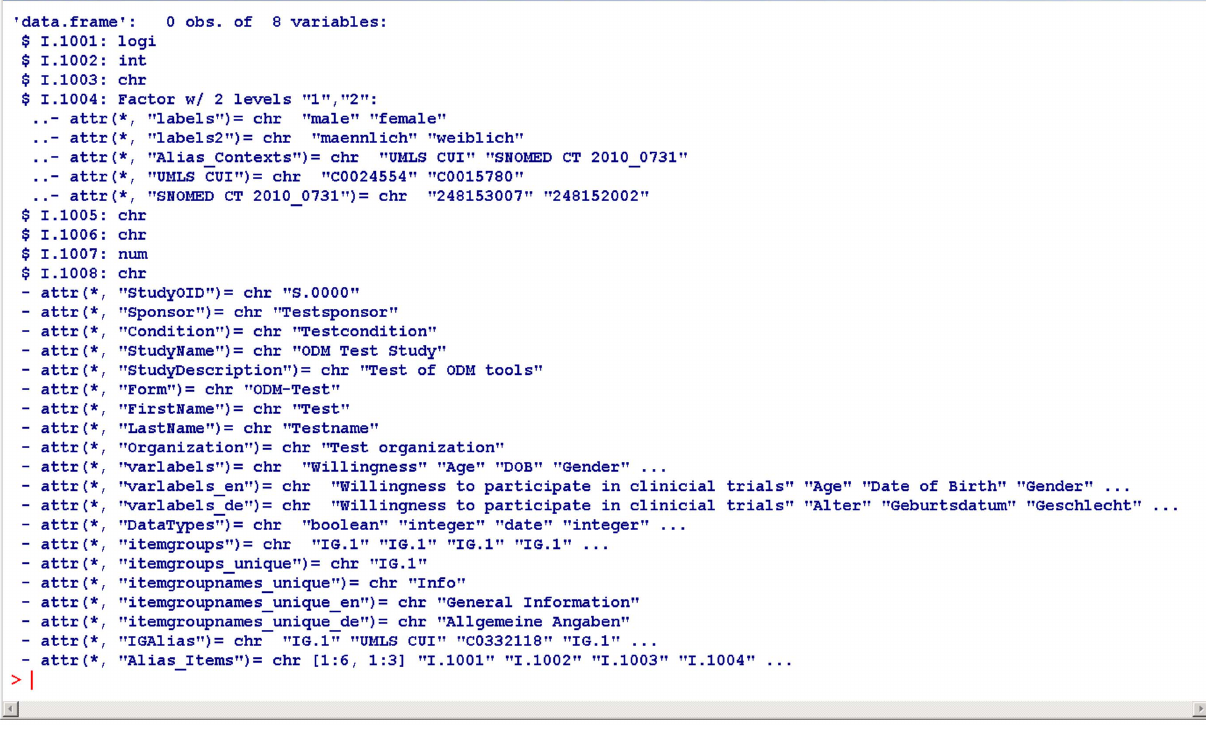
Table 2. Trial IDs, medical condition, number of items and number of annotation codes regarding 10 forms in ODM format, which were used for the evaluation (randomly selected from www.medical-data-models.org).